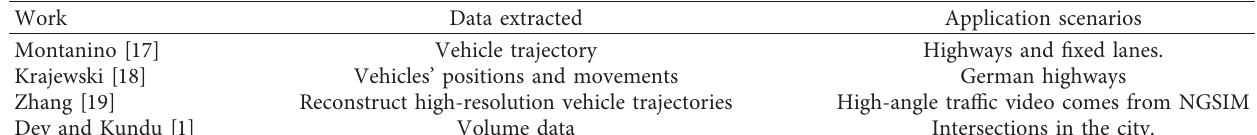
Table 2: Application scenarios for trajectory extraction